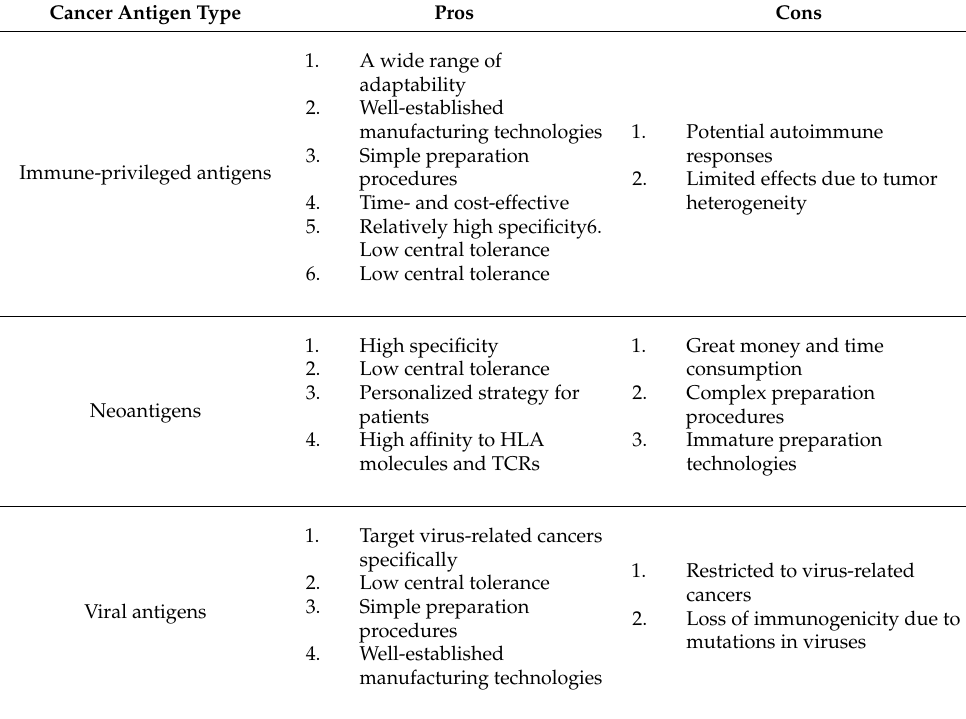
Table 2. Pros and cons of different tumor antigens in vaccine